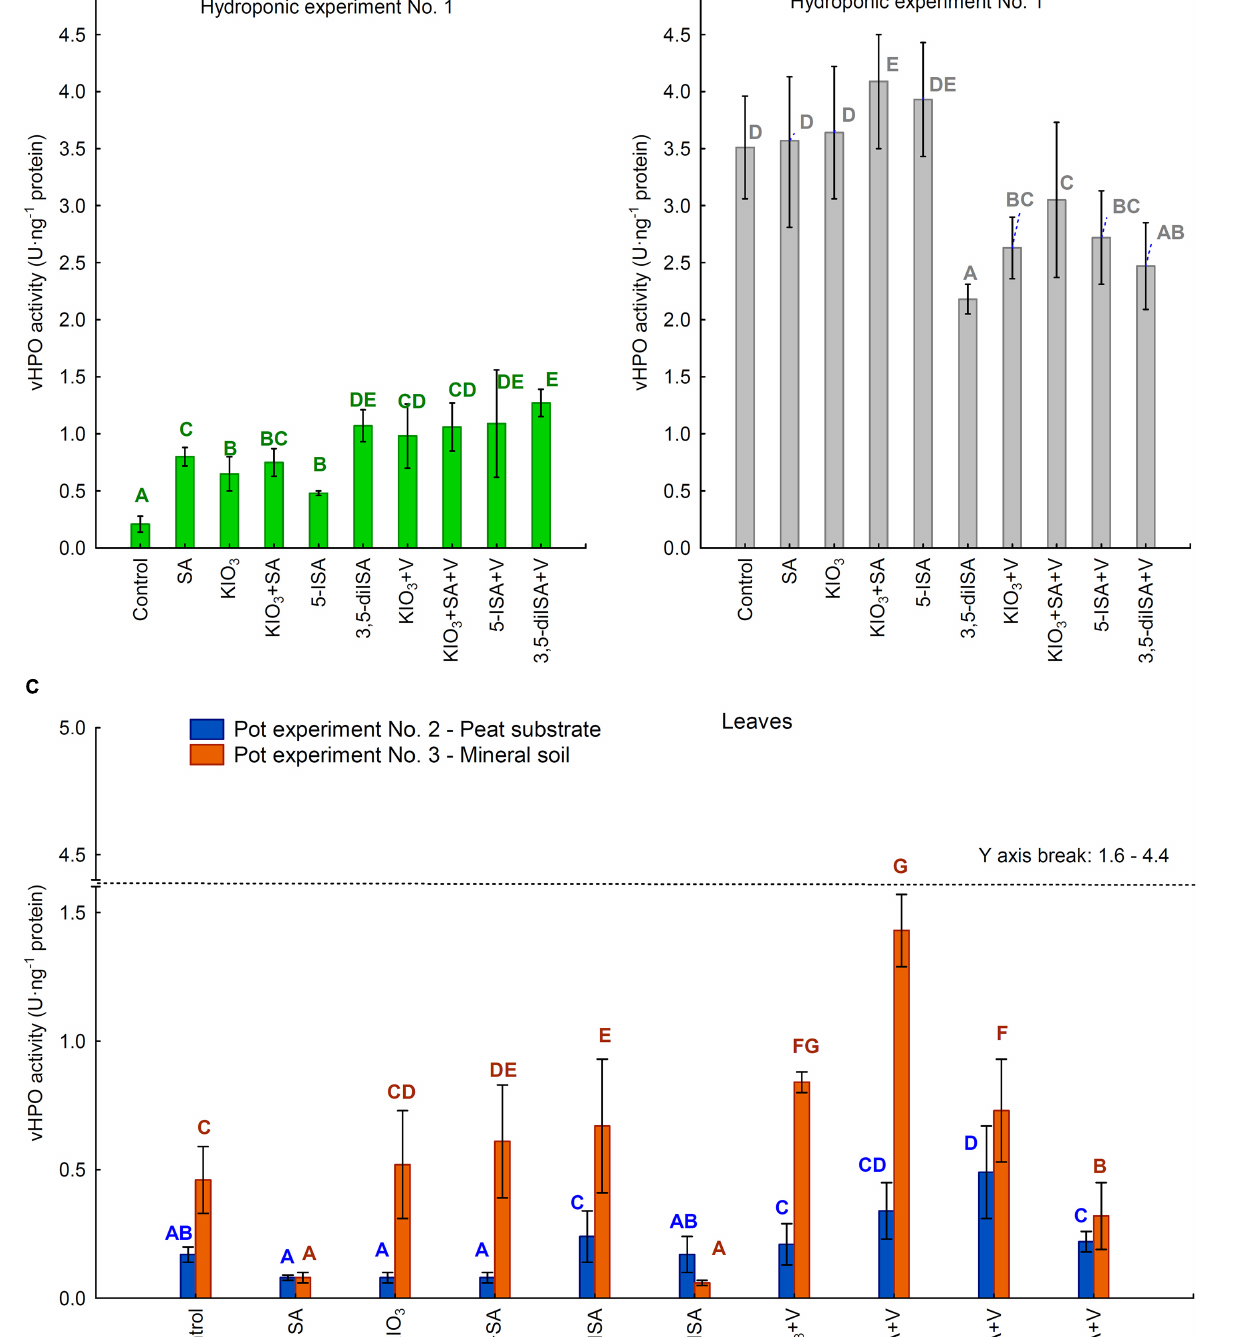
Frontiers in Plant Science |